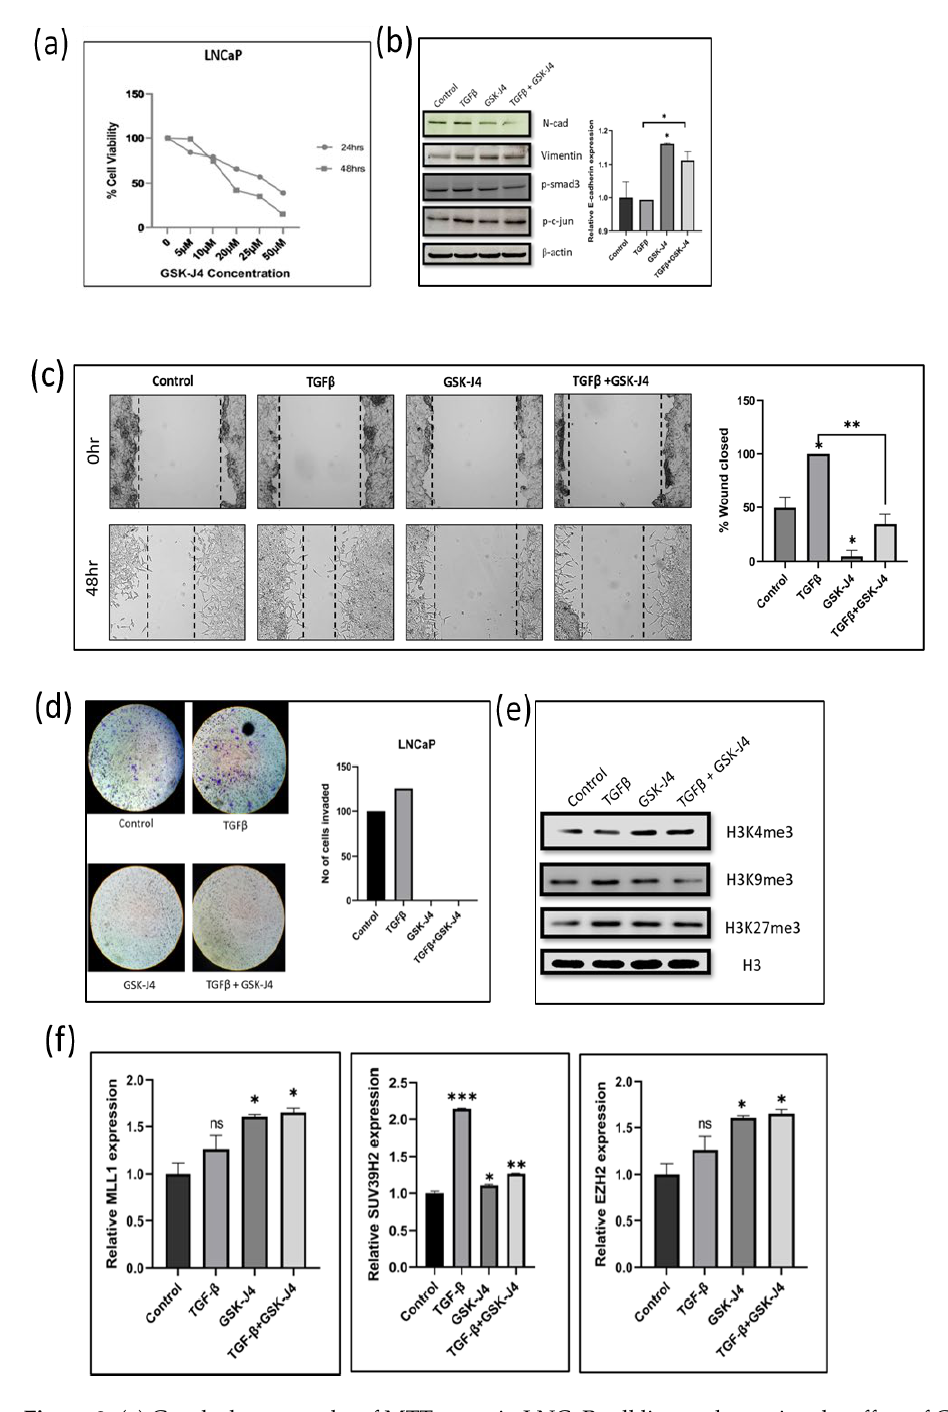
Figure 2. ( a ) Graph shows results of MTT assay in LNCaP cell line to determine the effect of GSK-J4 on cell proliferation. DMSO was taken as the vehicle control. ( b ) Western blot image of N-cadherin, p-smad, p-c-jun, and vimentin in LNCaP cell line after 48 h of treatment. β -Actin was taken as the loading control. The graph represents the relative quantification of E-cad mRNA in LNCaP cells upon treatment with GSK-J4 in the absence and presence of TGF β . GAPDH was taken as the endogenous gene control, and the gene expression was normalized with respect to the control (n = 3). ( c ) Microscopic images of LNCaP cells, as observed under a light microscope at a total magnification of 100 × . For wound healing assay, the cells were treated with GSK-J4 in the presence and absence of TGF β . The graph represents the % of wound area closed with respect to the 0 h time-point